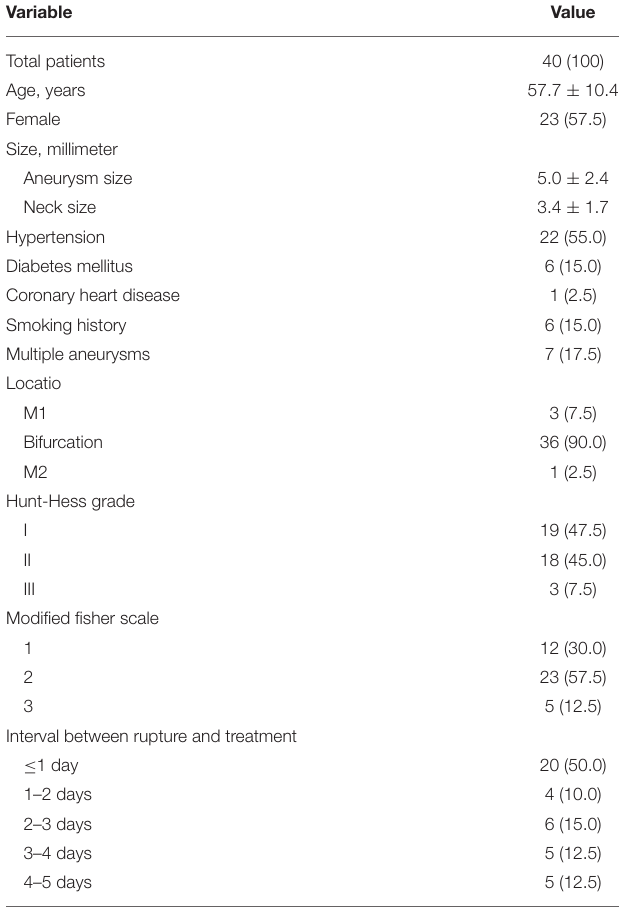
TABLE 1 | Summary of the demographics and aneurysm